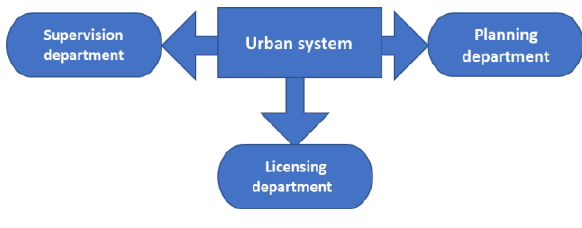
Figure 5. The three departments collaborating with an urban planning authority